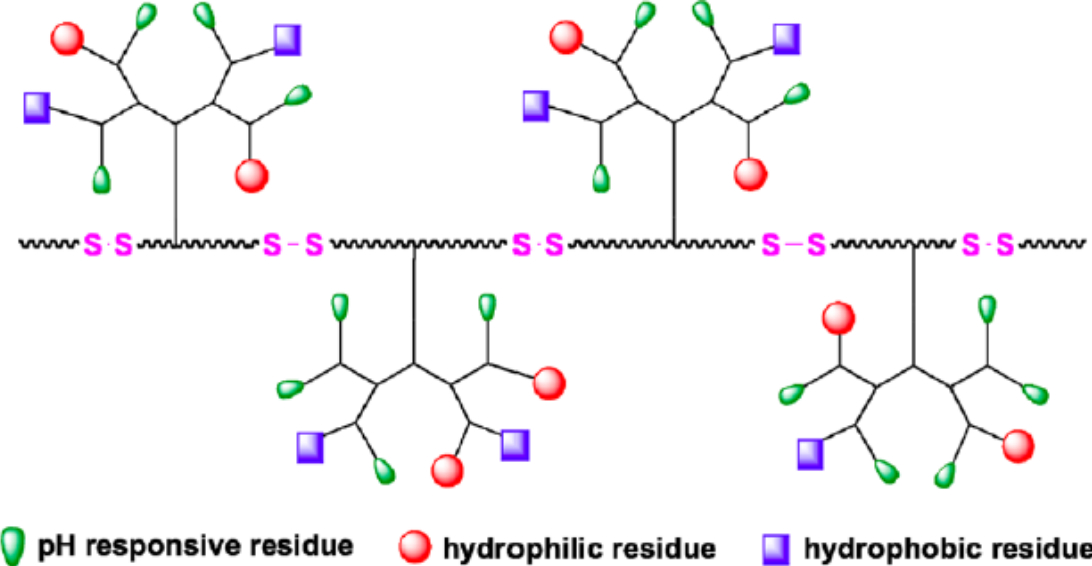
Figure 7. “Denpol”: A dendritic structure has been grown from a peptidic backbone that was produced by Scheme [94].